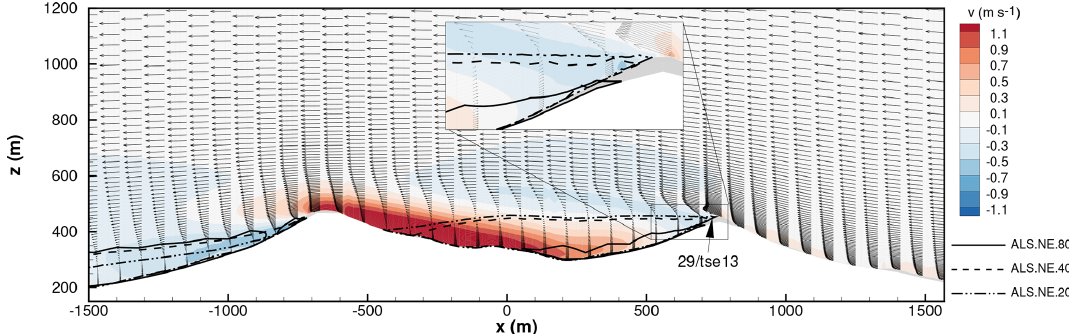
Figure 13. Impact of mesh resolution on separation zone in transect that crosses tower 29/tse13 in the case of NE